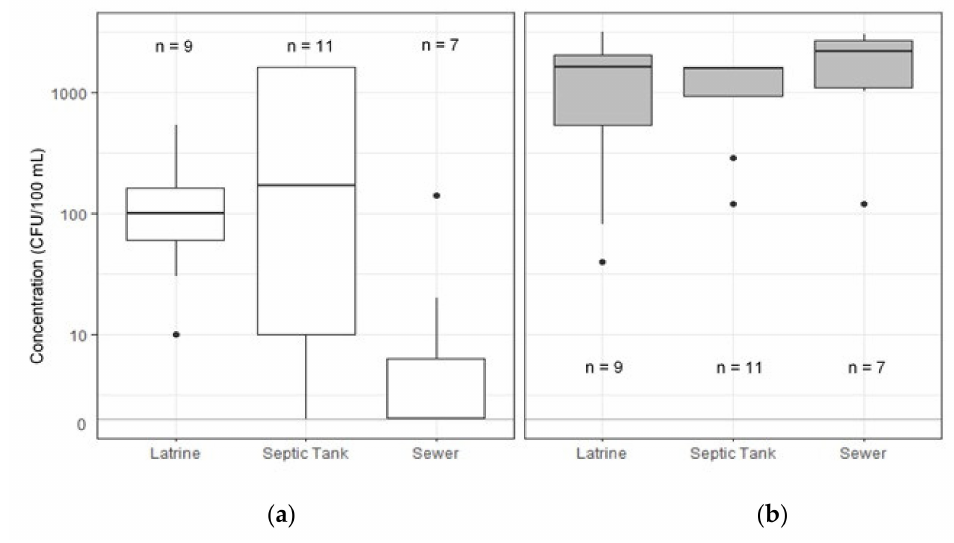
Figure 10. Distribution of ( a ) E. coli and ( b ) TC concentration in water samples at households using different types of sanitation facilities.